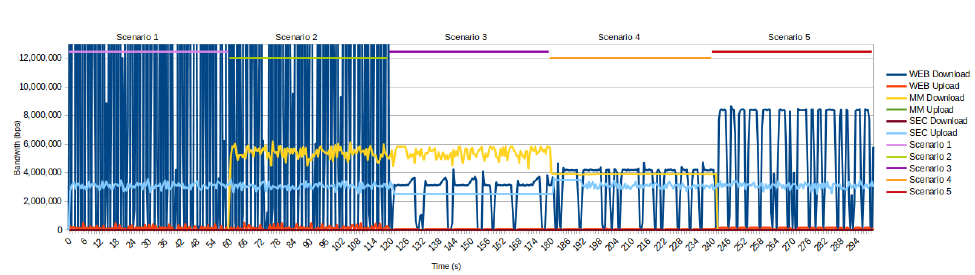
Figure 9. Bandwidth usage during testing